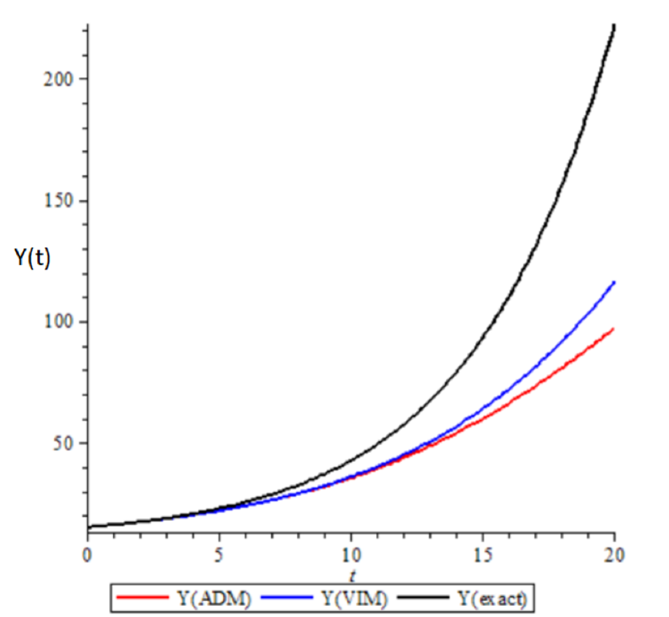
Fig. 1. Graphical output 𝑌 ( 𝑡 ) with 𝛼 = 0.9 for 𝑌 (0) = 15 , 𝑏 = 3 , ( 𝑃 − 𝑎 ) = 0.3 , 𝑚 = 25 , 𝑣 =